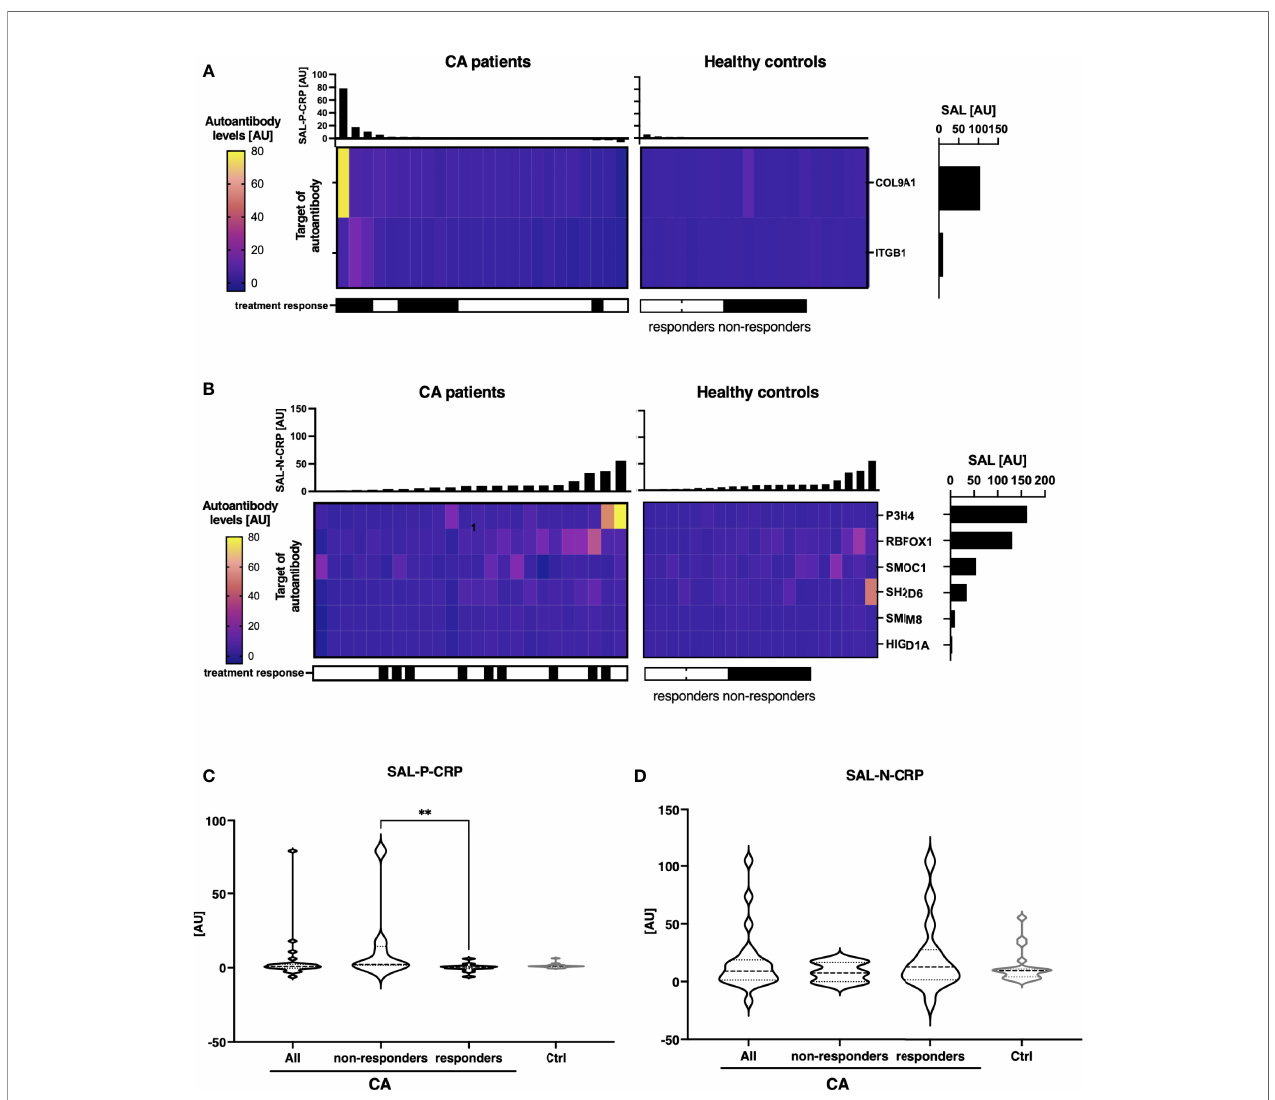
FIGURE 8 | Association between sum of autoantibody levels and clinical presentation in cutaneous arteritis patients. (A) Heatmap of 2 autoantibodies that positively correlate with serum levels of C-reactive protein (CRP) with statistical signi fi cance in individual sera of cutaneous arteritis (CA). The targets of autoantibodies are described with the gene symbols of their origin. SAL-P-CRP: sum of autoantibody levels that positively correlated with serum CRP levels with statistical signi fi cance. AU, arbitrary unit. (B) Heatmap of 6 autoantibodies that negatively correlate with serum CRP with statistical signi fi cance in individual sera of CA. The targets of autoantibodies are described with the gene symbols of their origin. SAL-N-CRP: sum of autoantibody levels that negatively correlates with serum CRP levels with statistical signi fi cance. (C) Violin plots of SAL-P-CRP in CA patients and healthy controls. Subpopulation analysis revealed that SAL-P-CRP was signi fi cantly elevated among treatment non-responders than among responders. P values were calculated by Mann-Whitney U test. (D) Violin plots of SAL-N-CRP in CA patients and healthy controls. ** P <